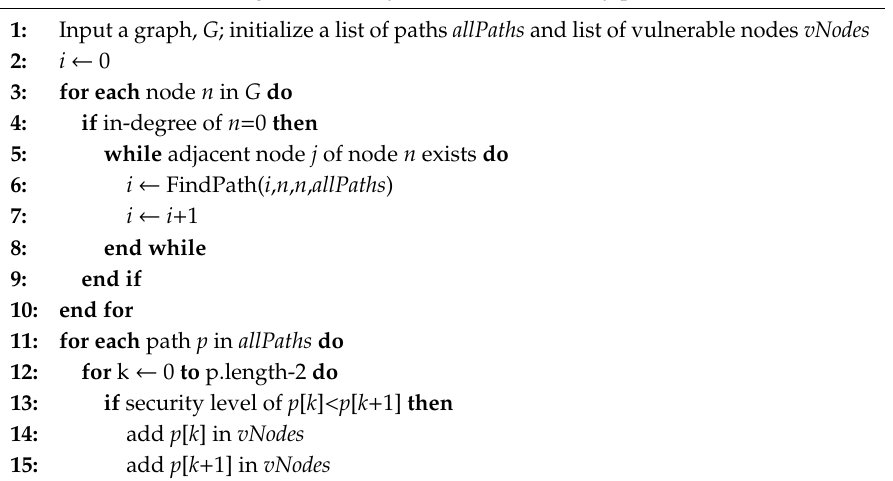
Algorithm 1 Determining vulnerability under confidentiality